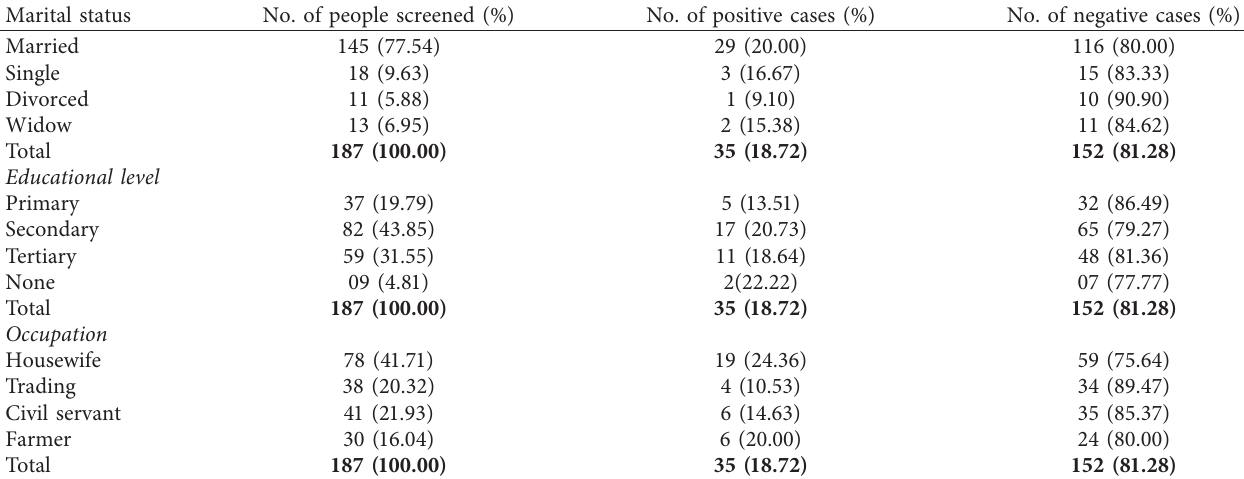
Table 2: Marital status, educational level, and occupational spread of the studied pregnant women.